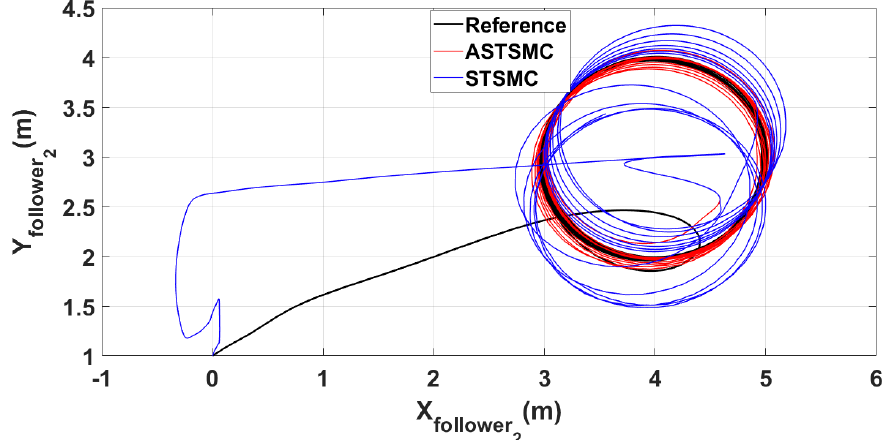
Figure 7. XY follower2 trajectory tracking comparison under wind disturbance.